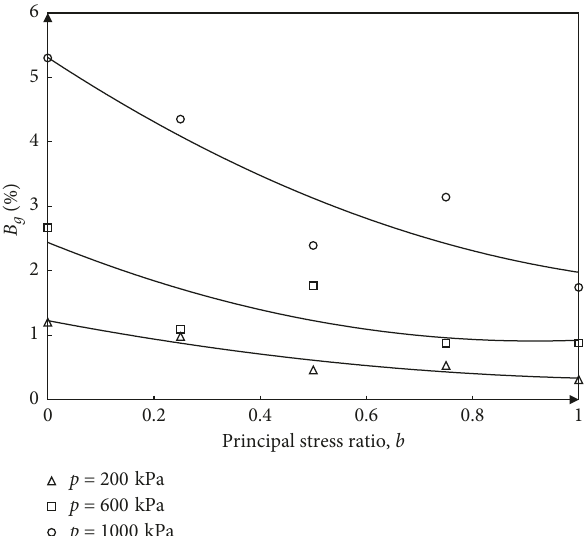
Figure 10: The relationship between the particle breakage rate and b for different mean